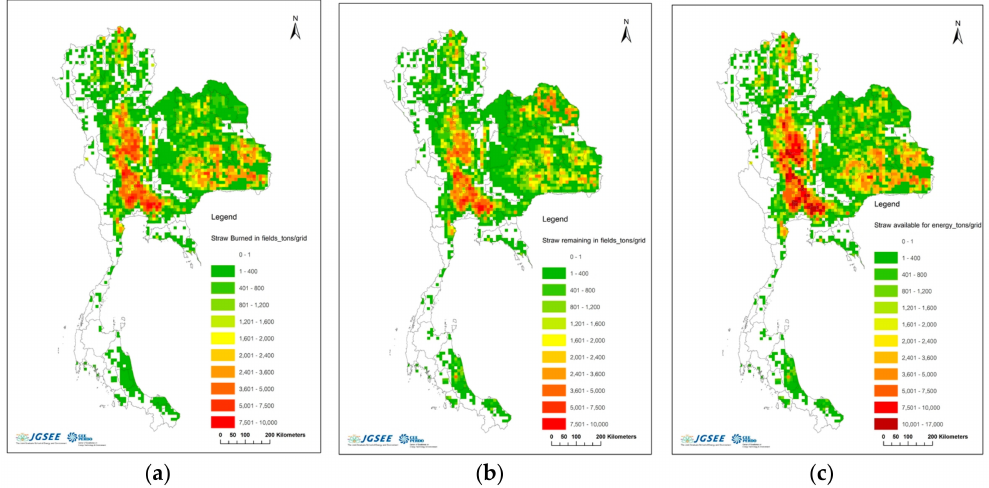
Figure 10. Spatial variation of the net potential of rice straws in Thailand obtained from ( a ) rice straw residue subjected to open-burning, ( b ) unused rice straw residue left in the field, and ( c ) total rice straws